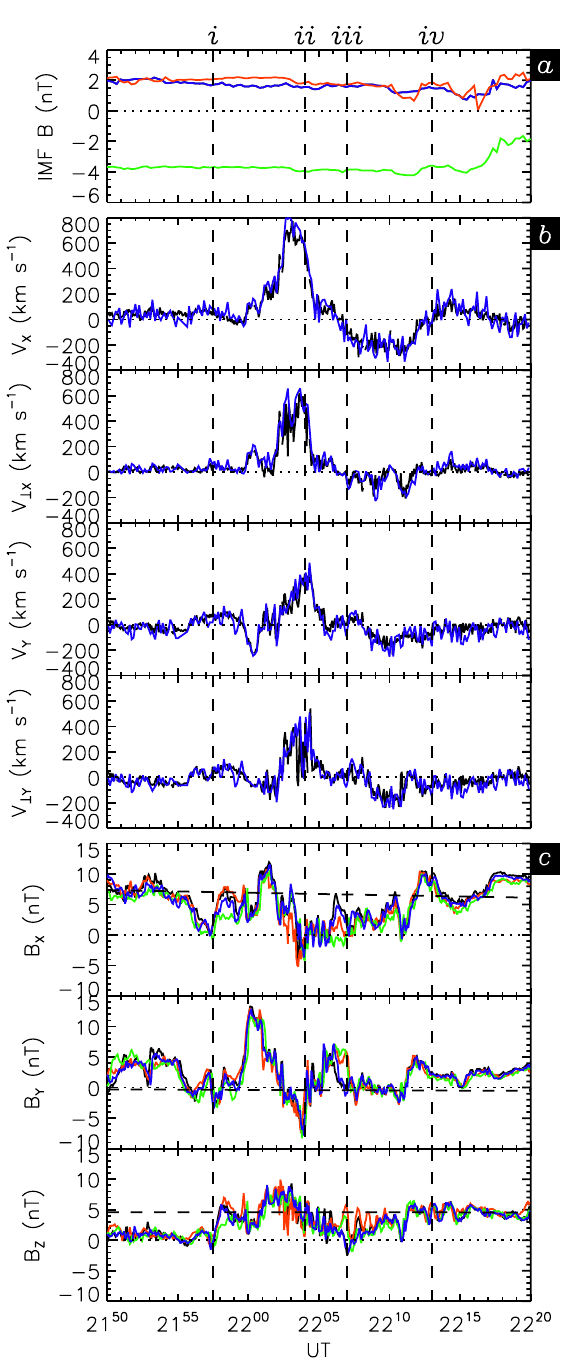
Fig. 3. Time series data from 21:50–22:20 UT on 14 August 2004. (a) The three GSM components of the lagged upstream IMF data from the ACE spacecraft: B X (blue), B Y (green), and B Z (red). (b) The X (top two panels) and Y (bottom two panels) GSM and mag- netic field perpendicular components of the ion flow as measured by the CIS instruments on two Cluster spacecraft (same colour coding as Fig. 1a). (c) The three GSM components of the magnetic field as measured by the FGM instrument on the four Cluster spacecraft (same colour coding as Fig. 1a). The vertical dashed lines indicate specific times of